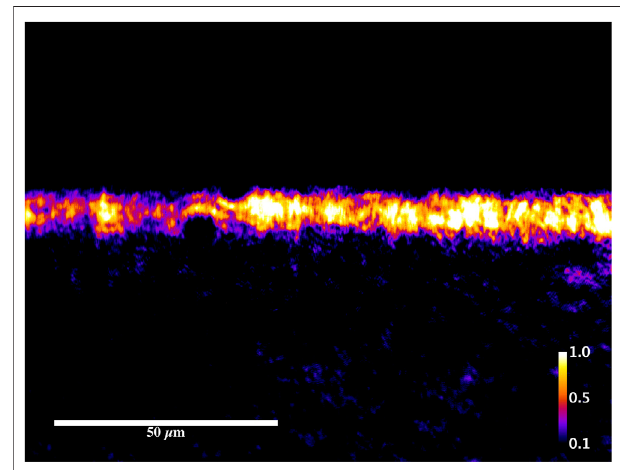
FIGURE 5 | Spatial propagating TE mode at 810 nm of the planar waveguide in the nc-YSZ ceramic after 24 h of annealing in air.